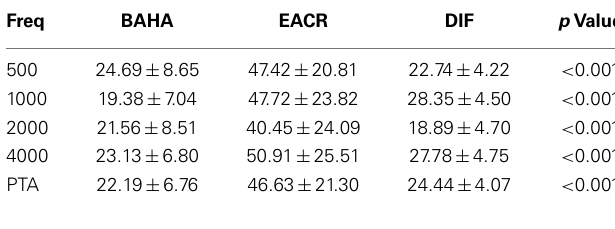
Table 4 | Long-term post-operative hearing thresholds comparison